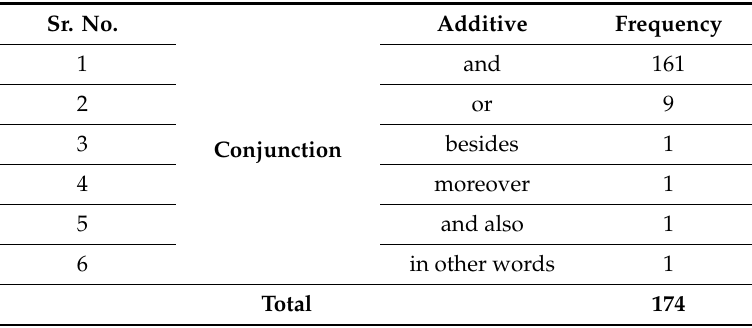
Table 5. Additive conjunctions.